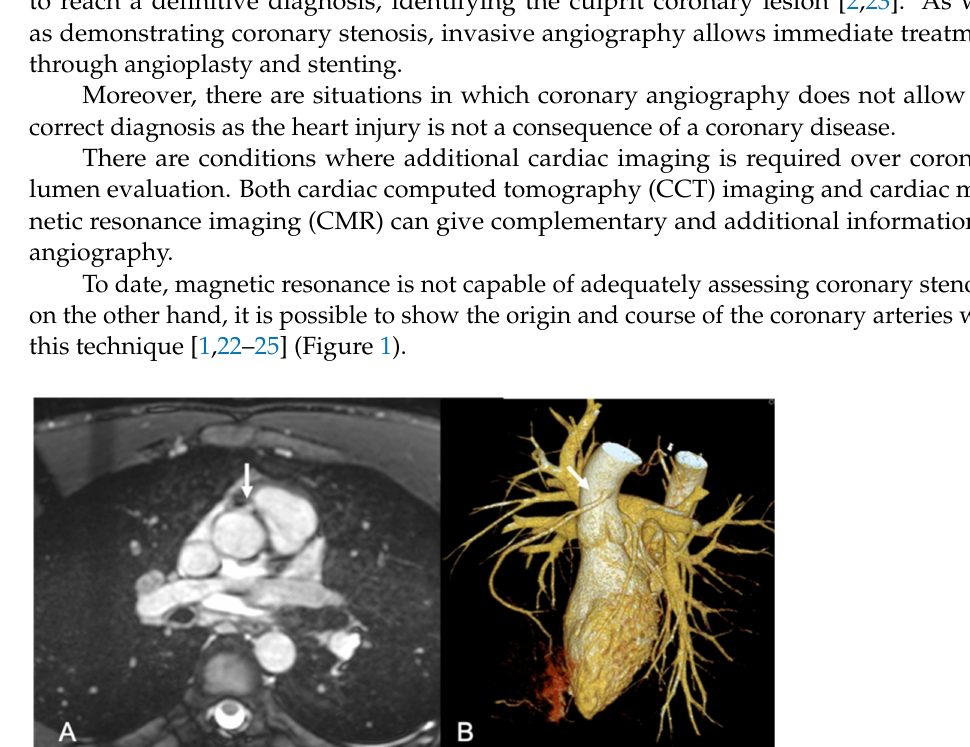
Figure 1. CMR performed for suspected cardiomyopathy in a 20-year-old male patient hospitalized for syncope and mild troponin elevation. A. In the whole-heart MR sequences without contrast agent, an anomalous origin of the right coronary artery (arrow) is present. The right coronary artery has a malignant course between the aorta and the trunk of the pulmonary artery ( A ). The CCT performed subsequently confirmed the coronary abnormality ( B